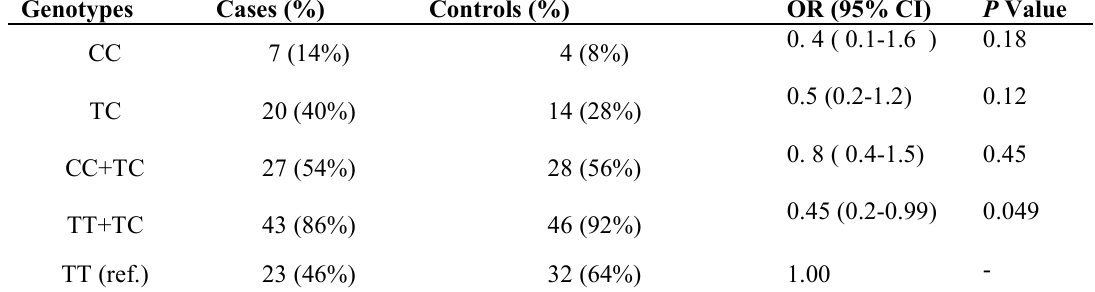
Table 2. The hsa-mir-196a2T/C genotype distribution OR: Odd ratio; CI: Confidence interval